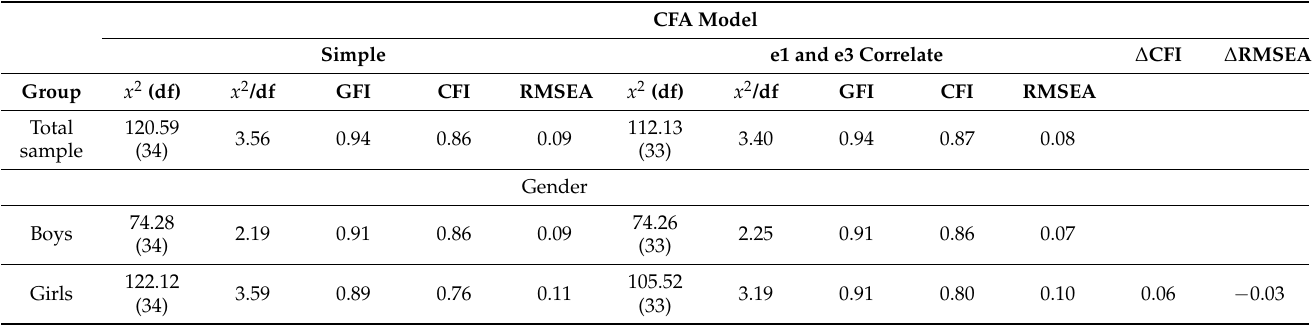
Table 6. Comparison of confirmatory factor analysis (CFA) models in Study 2. CFA